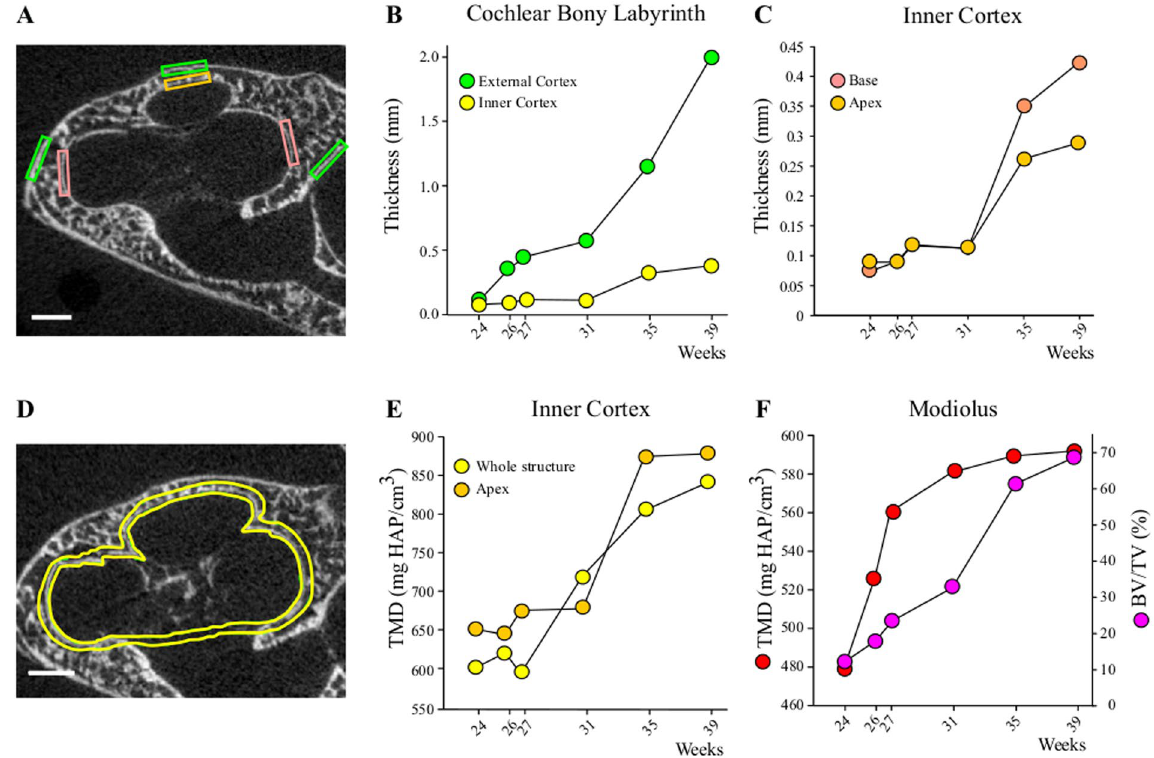
boxes) cortical bones on a μ CT section at 24 weeks. Bar = 1 mm. Progressive thickening of ( B ) the external and internal cortices and ( C ) the basal and apical region of the internal cortical bone at successive weeks of gestation. ( D ) ROI definition for μ CT analysis of the inner cortical bone (yellow lines) on a μ CT section at 26 weeks. Time-courses of tissue mineral density (TMD) increase ( E ) in the apical (ROI = apical orange box in A ) and the whole inner cortical bone (ROI in D ) and of the ossification (BV/TV) and TMD increase in the modiolus ( F , see Methods for ROI), at successive weeks of